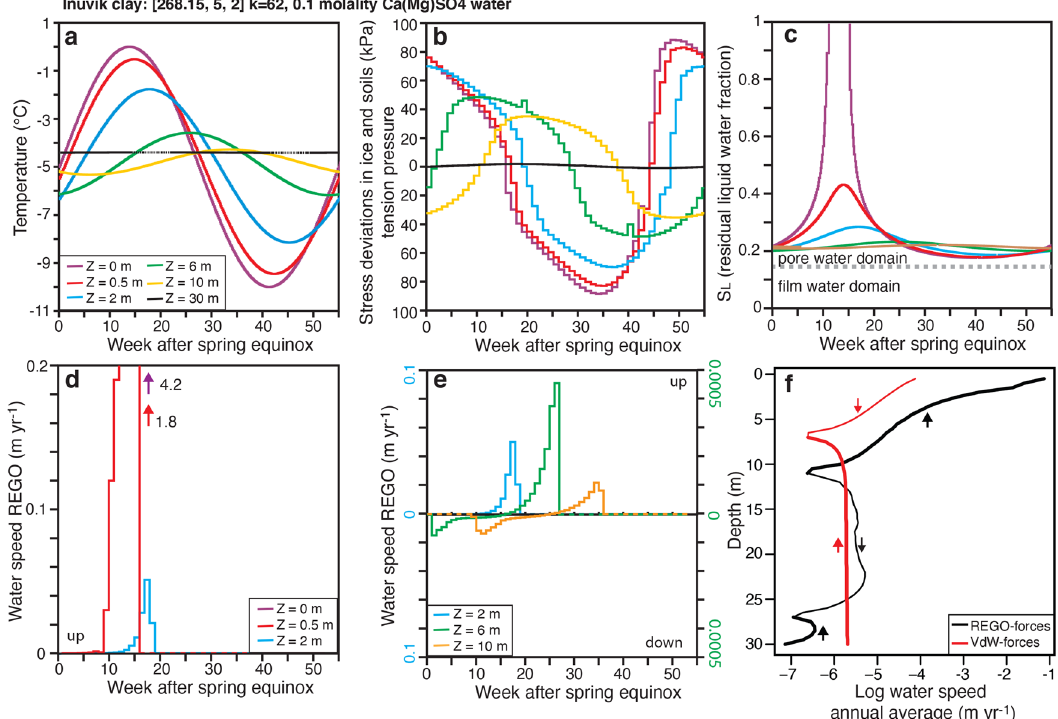
Fig. 4 Typical weekly variations in ground temperature, stress, and unfrozen water content, and the REGO-induced water speeds within Inuvik clay permafrost with Ca(Mg)SO 4 water chemistry. Weekly variations measured from the spring equinox in a ground temperature, b stress deviations in permafrost, c unfrozen water content, d , e maximum water speeds induced by REGO forces in 30 m Inuvik clay permafrost with Ca(Mg)SO 4 water chemistry, and f pro fi les of annual averages water speed from REGO forces and VdW forces up to 30 m depth. Data are presented from the spring equinox. Numerical simulation was performed for mean annual ground surface temperature of − 5 °C, amplitude of 5 °C, and thermal diffusivity of 62 m 2 yr − 1 . Table 3 lists values used in the WATEREGO